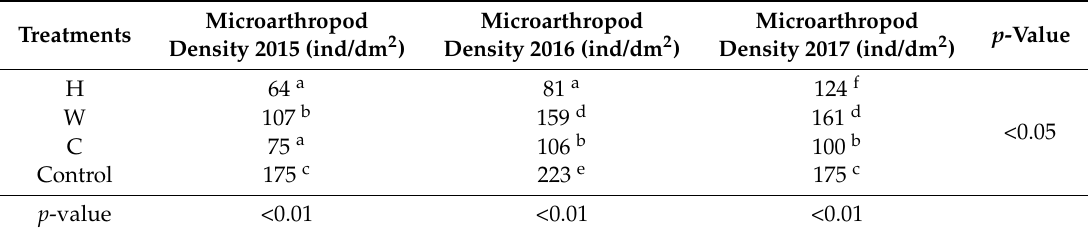
Different letters show significant differences among values in a column (Tukey